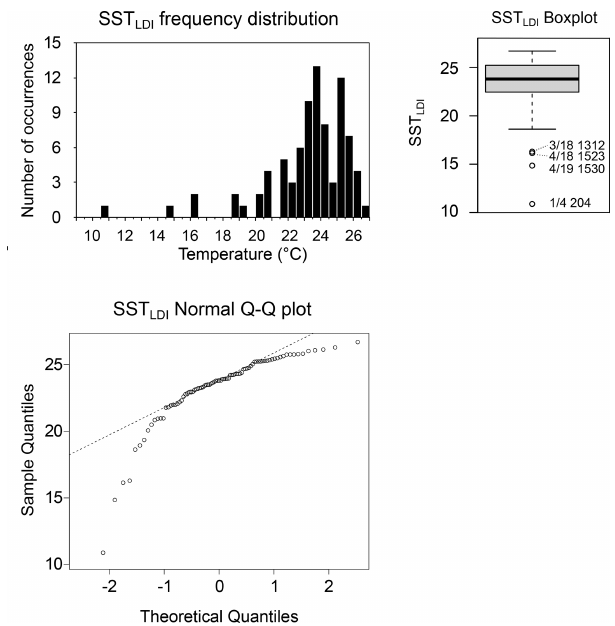
Figure 7. Statistics of the SST LDI values identifying the four val- ues below 16 ◦ C as outliers. (a) Frequency distribution. (b) Boxplot with outliers indicated with trap deployment number and the cup number of that trap separated by a slash and followed by the day (since the start of 2003) the cup was halfway through its deploy- ment. (c) Q–Q plot, with the dotted line representing the expected values for a normally distributed